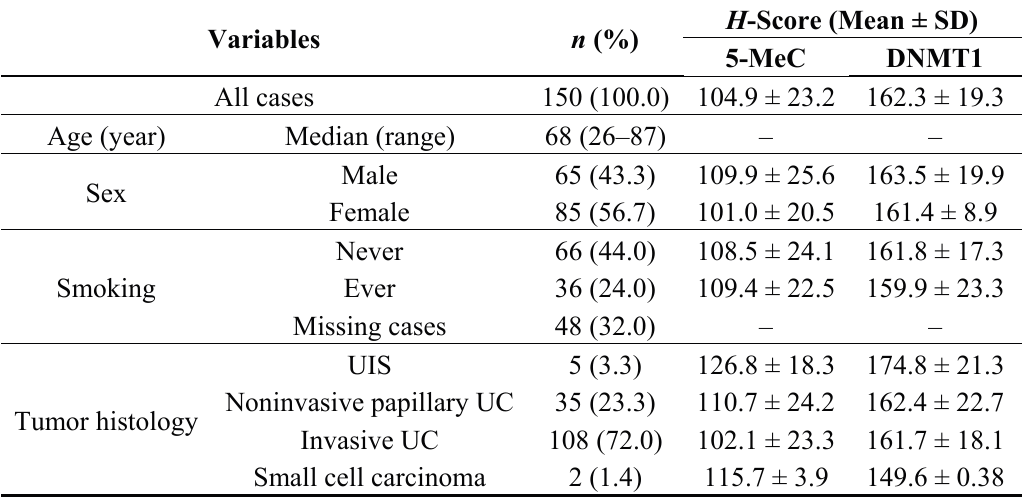
Table 1. Clinicopathologic variables of patients with urothelial carcinomas